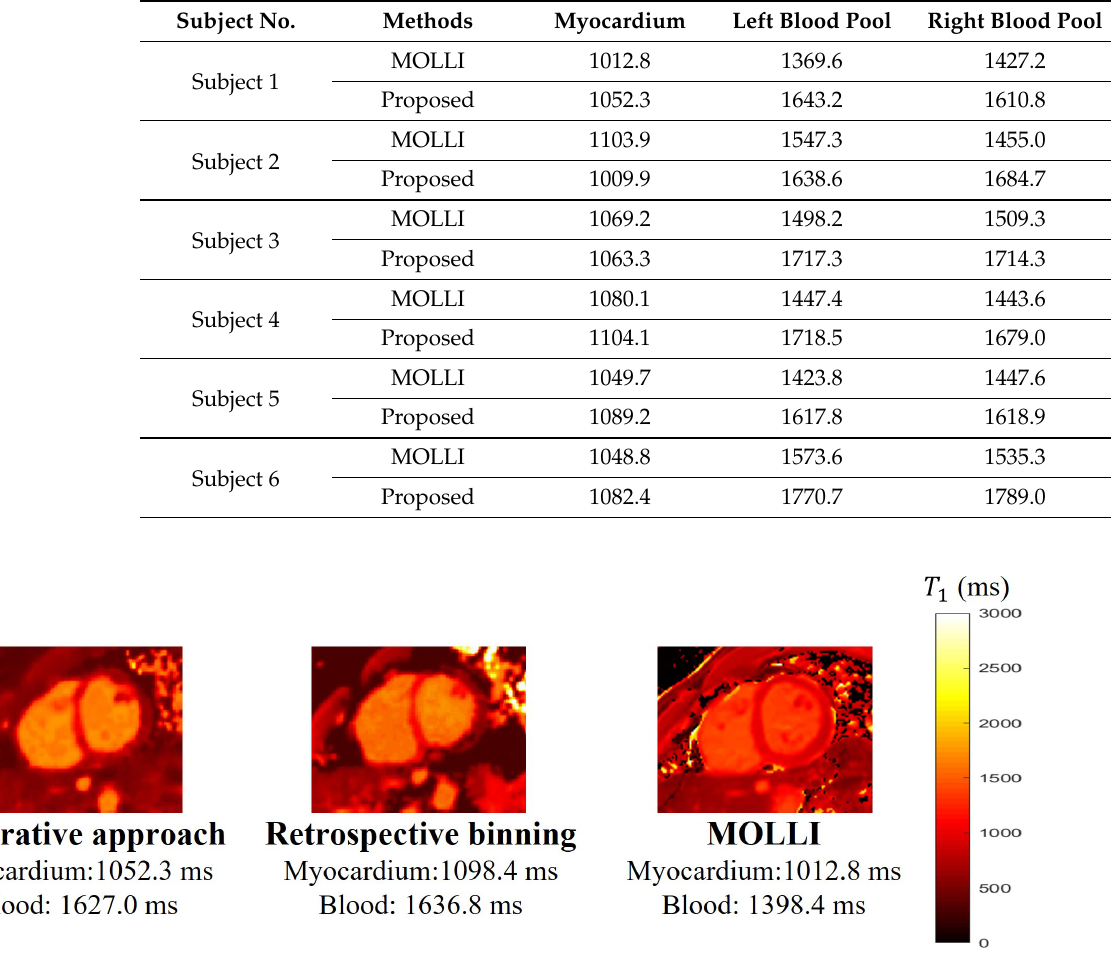
Table 3. The average T 1 values for myocardium, left blood pool, and right blood pool estimated from MOLLI and the proposed scheme. Results from six subjects are shown in the table.